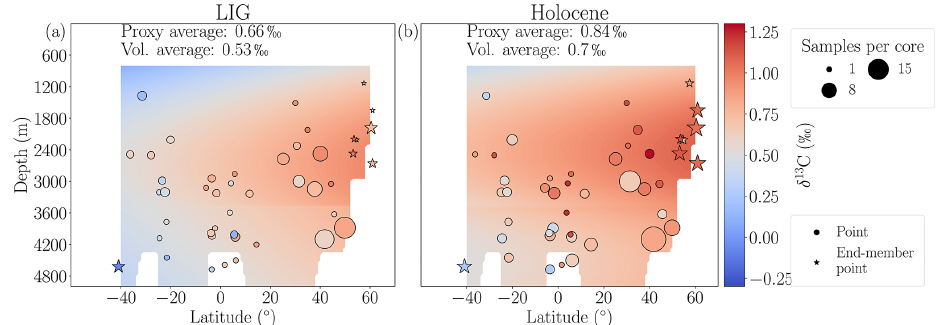
Figure 7. Reconstructed Atlantic δ 13 C (‰) meridional section during the LIG (125–120kaBP) and Holocene (7–2kaBP). The circular points represent the proxy data, showing the average δ 13 C with colour and the number of points per core with size. The stars represent the proxy data that make up the end members. Background shading shows the reconstructed δ 13 C using a quadratic statistical regression of the proxy data following the method described in Bengtson et al. (2019).